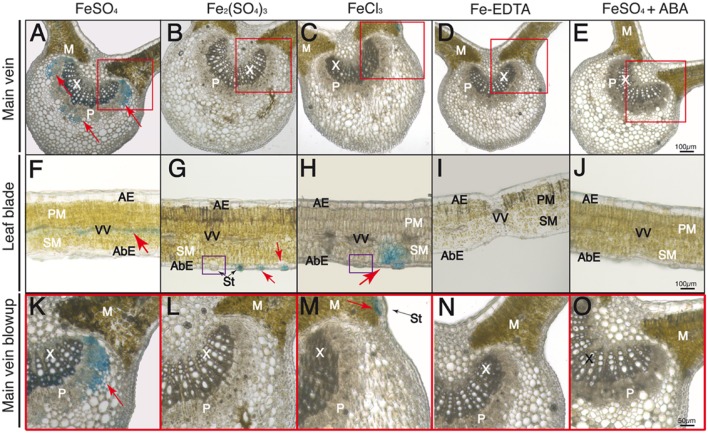
Localization of labile Fe pools using Perls blue staining in transversal leaf sections taken 90 min after Fe foliar fertilization: main vein (A–E), leaf blades (F–J) and close-up of main vein areas in red squares in (A–E)(K–O). Leaves were treated with FeSO4
(A,F,K), Fe2(SO4)3
(B,G,L), FeCl3
(C,H,M), Fe(III)-EDTA (D,I,N) and FeSO4 in ABA-treated plants (E,J,O). Phloem and xylem tissues (P and X, respectively) and mesophyll tissue (M) are marked in images (A–E) and (K–O); abaxial and adaxial epidermis (AbE and AE), parenchima and spongy mesophyll tissue (PM and SM), stomata (St) and vascular vessels (VV) are marked in images (F–J). Purple squares in (G,H) indicate stomata without blue stain. The scale bars correspond to 100 and 50 μm in (A–J) and (K–O), respectively.